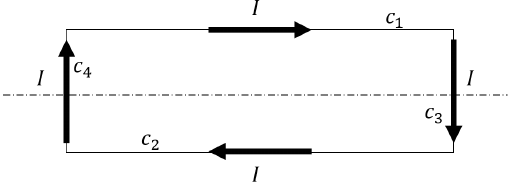
Figure 2. Rectangular current loop representing a winding